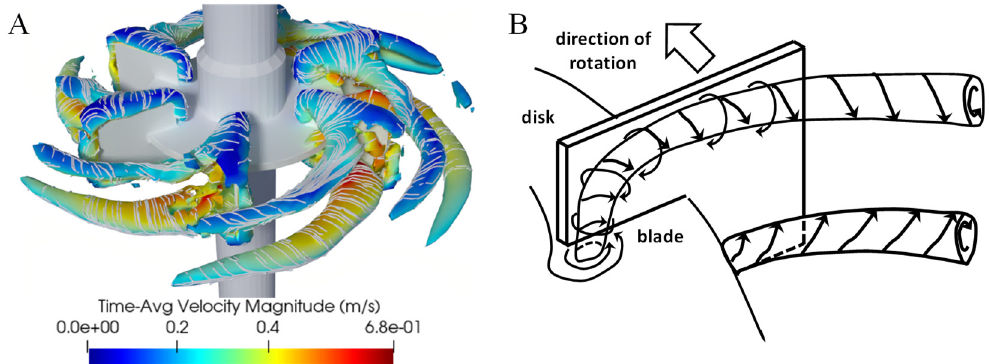
Figure 7. Time-averaged (at fixed blade to baffle position) trailing vortices simulated with M-Star ( A ) and adopted from Van’t Riet [45] ( B ). Reprinted with permission from ref. [45]. Copyright 2021 Elsevier.